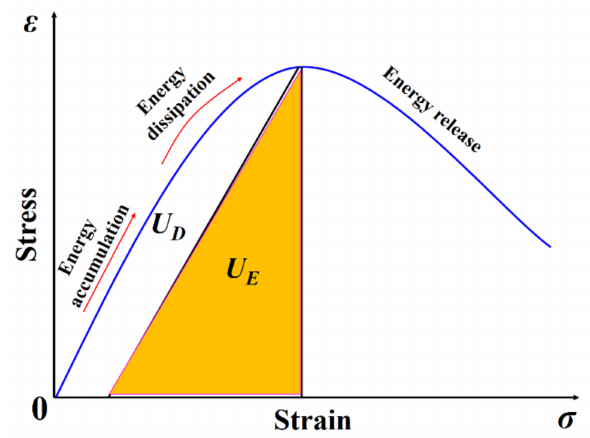
Figure 9. RCF sample energy evolution